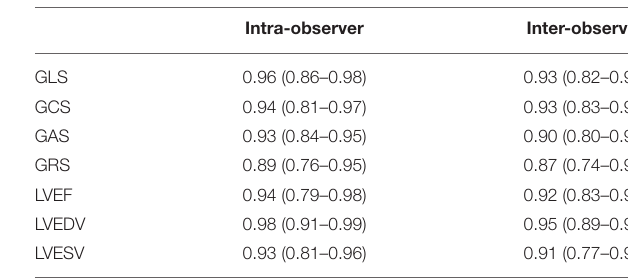
TABLE 3 | Intra-observer and inter-observer reproducibility for 3D echocardiographic